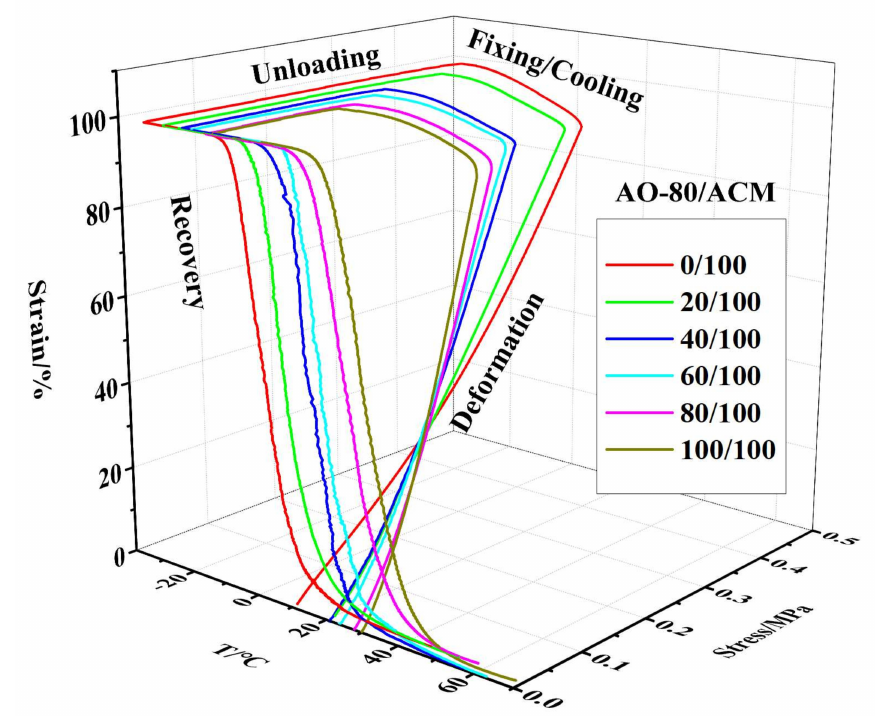
Figure 6. 3D ε -T- σ curve of various compositions for AO-80/ACM rubber composites.